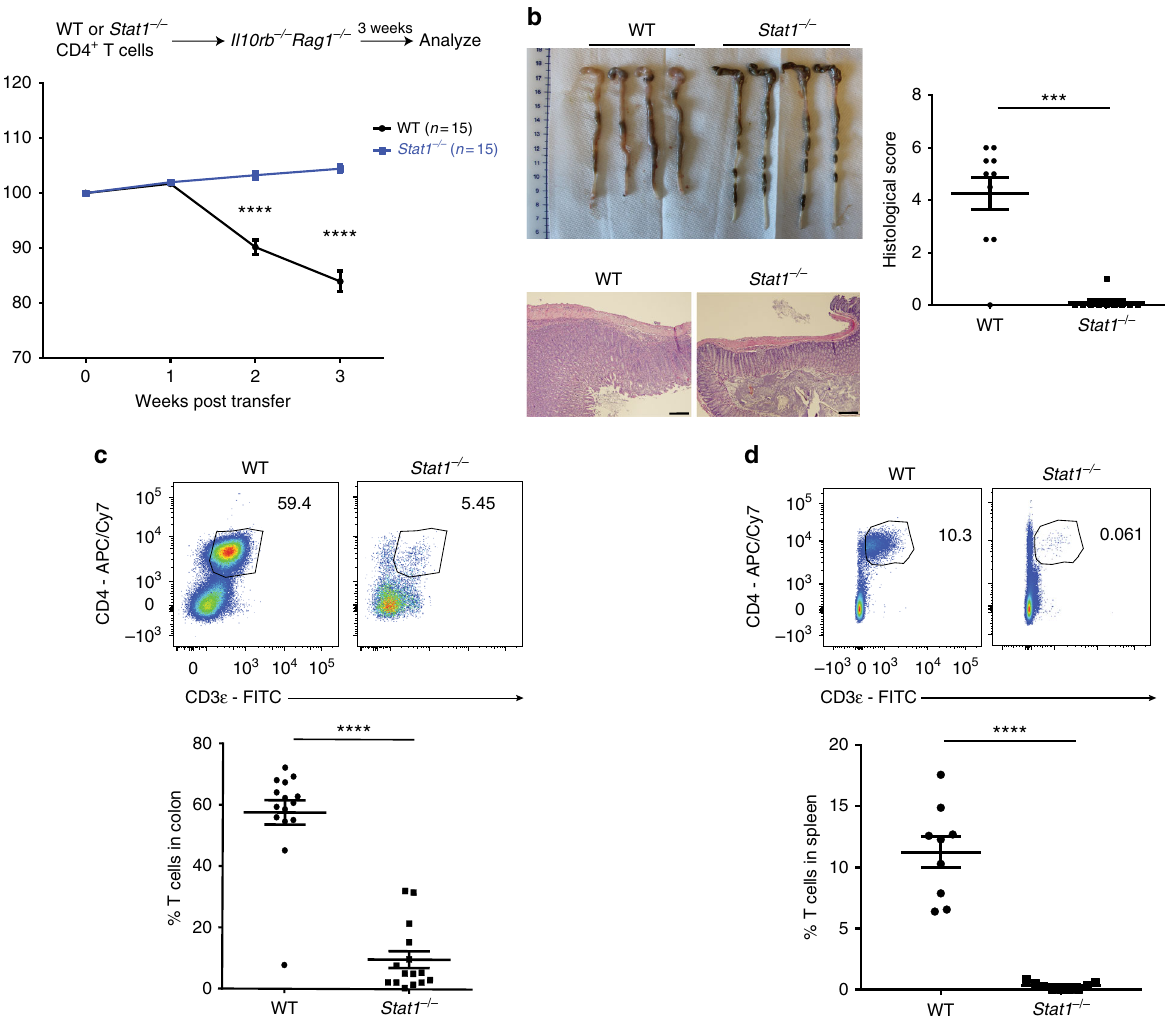
Fig. 1 Stat1 − / − T cells fail to induce colitis due to defective expansion. Il10rb − / − Rag1 − / − mice were injected i.p. with 1 × 10 6 unfractionated WT or Stat1 − / − CD4 + T cells. a Mean % original body weights ± SEM following T-cell transfer. Source data are provided as a Source Data fi le. b Representative images of colons, as well as representative H&E images of distal colon sections with mean histological scores ± SEM at 3 weeks post transfer. Scale bar represents 200 µ m. c , d Representative fl ow cytometry plots of CD4 + T cells (gated on live CD45 + cells, Supplementary Fig. 4a) in the c colon and d spleen followed by their mean frequencies ± SEM at 3 weeks post transfer. All data are pooled from two to three independent experiments, with each point representing an individual mouse. **** p < 0.0001, *** p < 0.001 by a two-way ANOVA with Bonferroni ’ s correction or b – d two-tailed Mann – Whitney